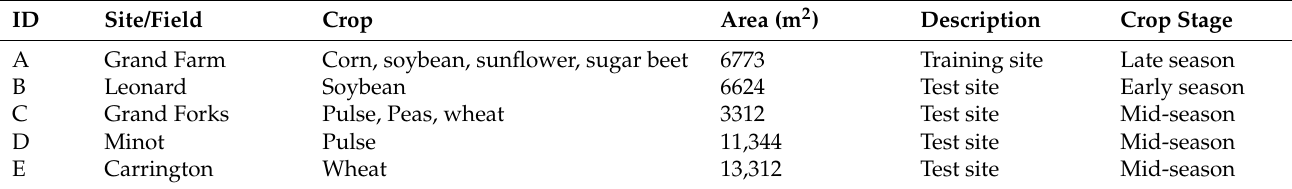
Table 1. The descriptive statistics of study sites in North Dakota,